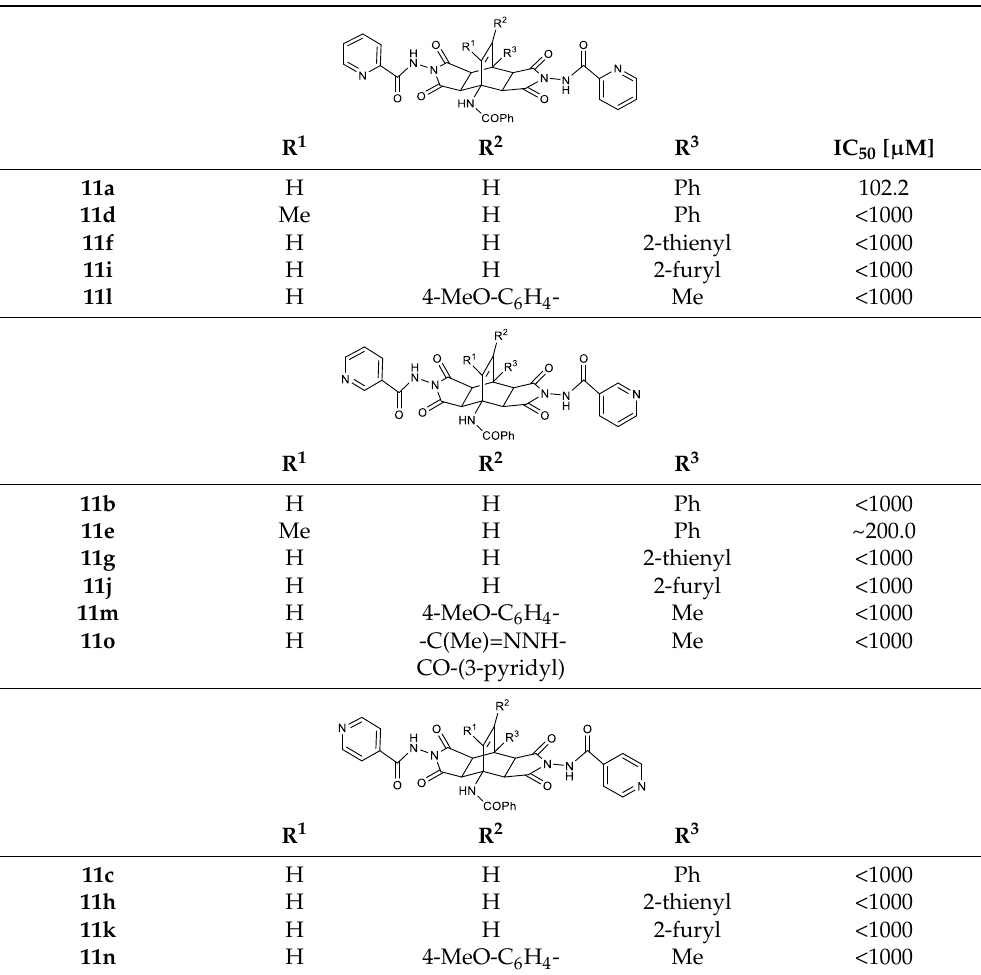
Table 2. Results of the inhibition assay for fused bicyclo[2.2.2]octene 11a – o a .